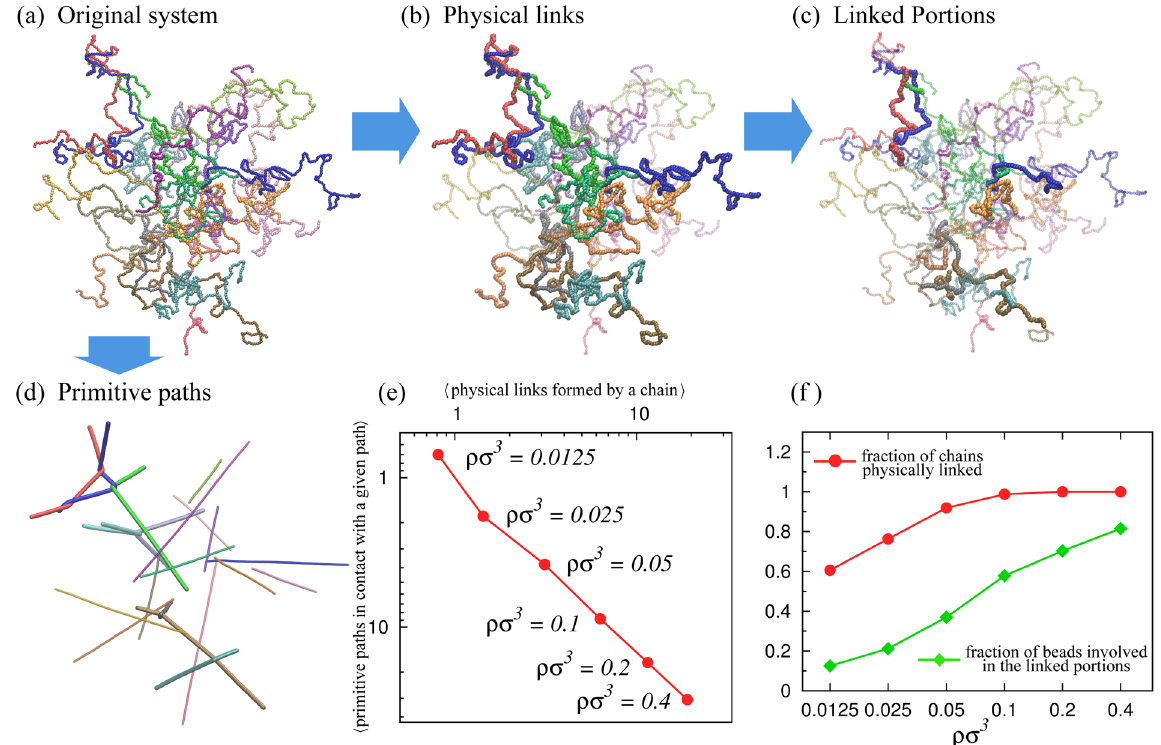
Figure 5. Physical links in melts: ( a ) Equilibrated configuration of a solution of 20 semiflexible linear chains ( l p = 5 σ ) each with 250 beads of diameter σ . The system has a monomer concentration ρσ 3 = 0.0125. ( b ) Topological characterisation of configuration ( a ) made in terms of physical links (brighter and thicker chains). For comparison the corresponding primitive path representation is given in panel (d) where paths with at least one kink are made thicker. In panel (d) only the linked portions of the physical links in ( b ) are highligthed. Note that, unlike the primitive path representation ( d ) the one based on either physical links ( b ) or linked portions ( c ) resides in the original configurational space. ( e ) Quantitative comparison, at different solution density, betwen description ( b , d ) made in terms of the average number of physical links experienced by a chain vs the average number of primitive paths in contacts with a given path. ( f ) Fraction of chains that are physically linked (red circles) and fraction of beads involved in the linked portions (green